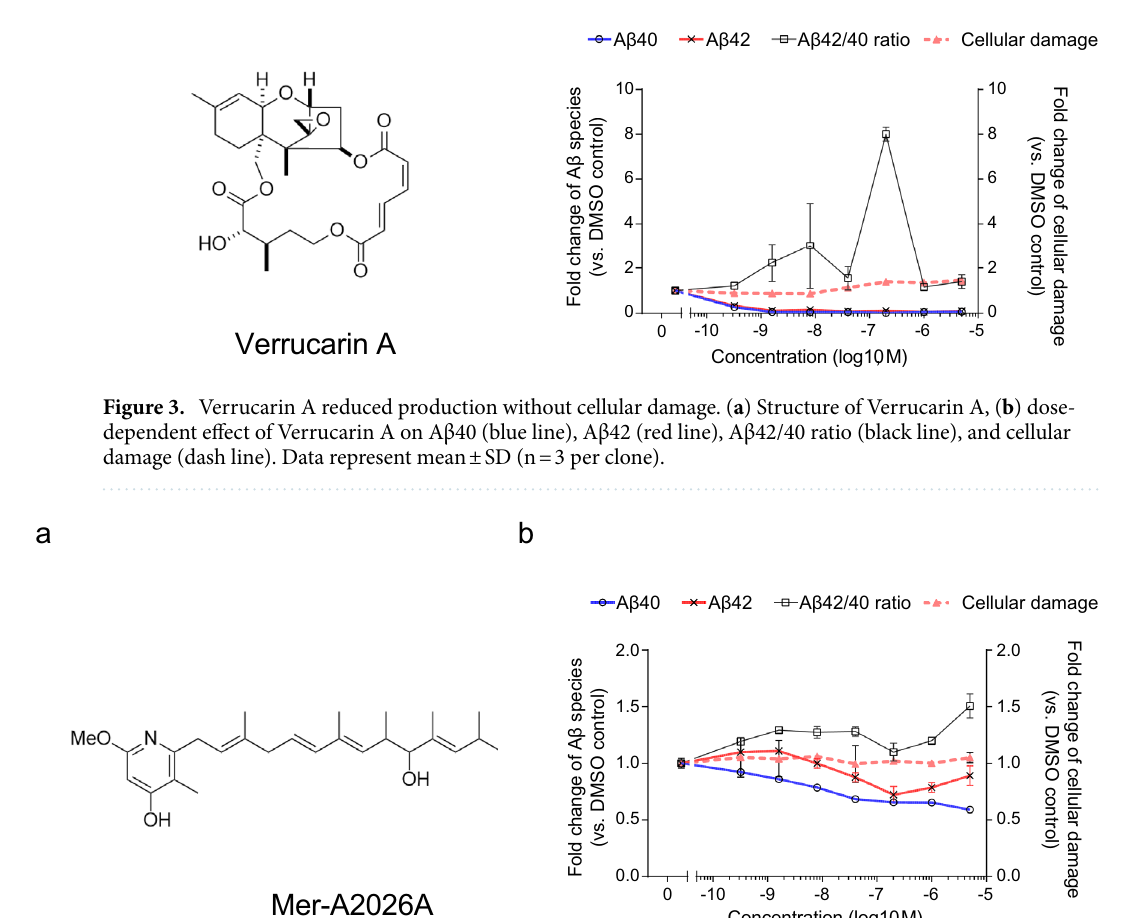
Figure 4. Mer-A2026A upregulated Aβ42/40 ratio at low concentration and reduced Aβ production at high concentration. ( a ) Structure of Mer-A2026A, ( b ) dose-dependent effect of Mer-A2026A on Aβ40 (blue line), Aβ42 (red line), Aβ42/40 ratio (black line), and cellular damage (dash line). Data represent mean ± SD (n = 3 per